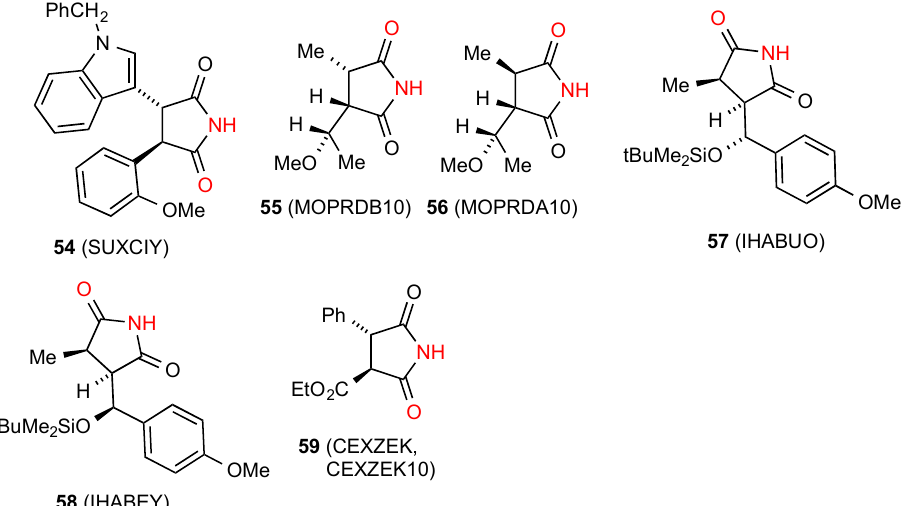
Figure 20. 3,4-Disubstituted succinimides with patterns A and B.